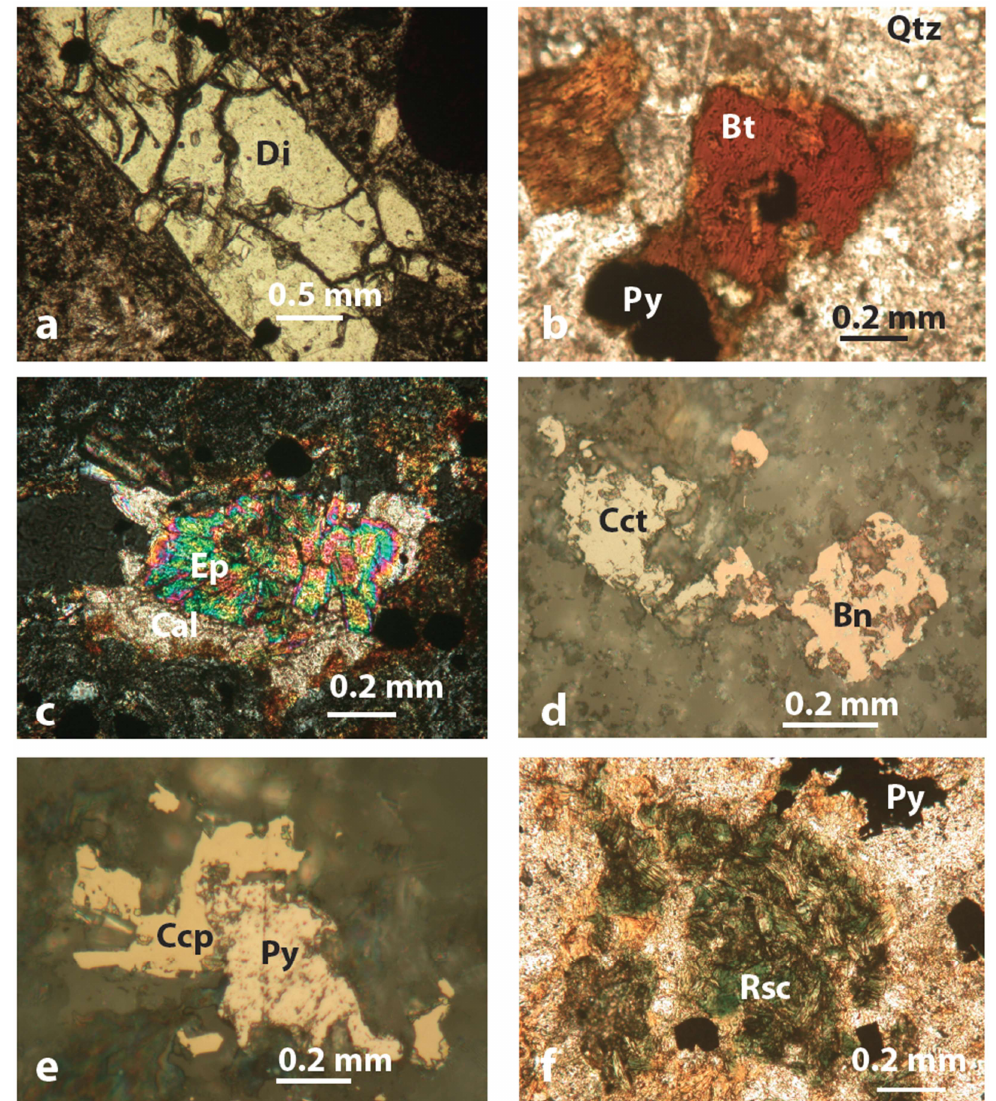
Figure 3. ( a ) Transmitted light (plane polarized) photomicrograph of diopside (Di) in typical monzonite in a fine-grained plagioclase matrix. ( b ) Transmitted light (plane polarized) photomicrograph of biotite (Bt) and pyrite (Py) in moderately altered monzonite. ( c ) Transmitted light (cross polarized) photomicrograph of propylitic alteration consisting of epidote (Ep) and calcite (Cal) in micromonzite, Central Ridge Cu prospect. ( d ) Reflected light (plane polarized) image of chalcocite (Cct) and bornite (Bn), Central Ridge Cu prospect. ( e ) Reflected light (plane polarized) image of chalcopyrite (Ccp) and pyrite (Py) in the Banana Creek prospect. ( f ) Transmitted light (plane polarized) image of roscoelite (Rsc) and pyrite (Py) in phyllic alteration, Banana Creek. Mineral abbreviations are after Whitney and Evans [38] except for roscoelite, which was not included in their